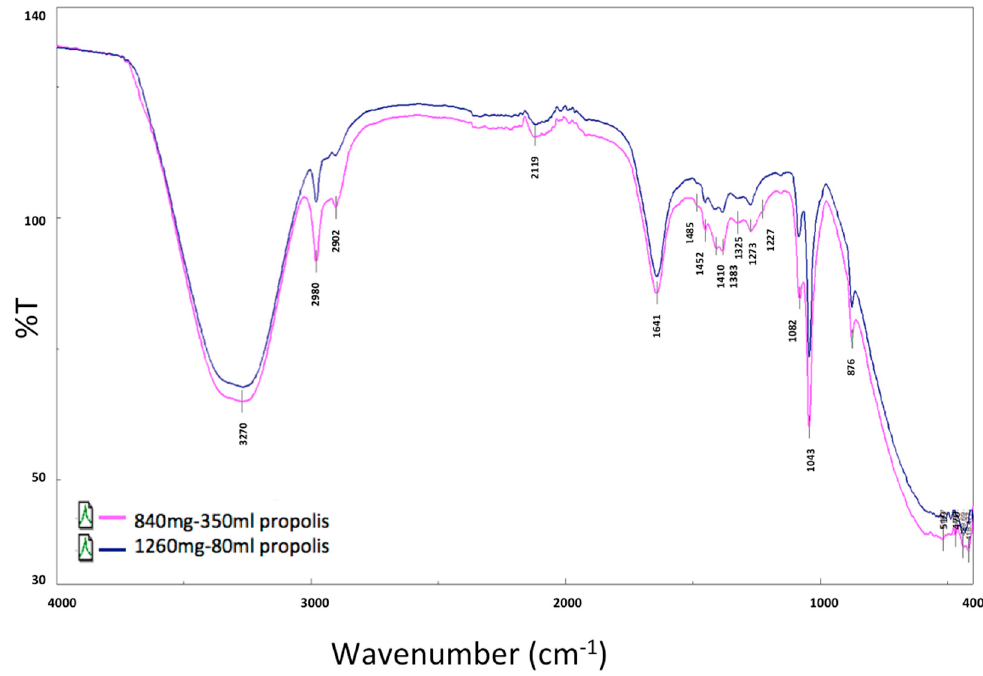
Figure 8. Nano-propolis-10 (NP-10; 840 mg / 350 mL) and nano-propolis-30 (NP-30; 1260 mg / 180 mL) for FTIR data.